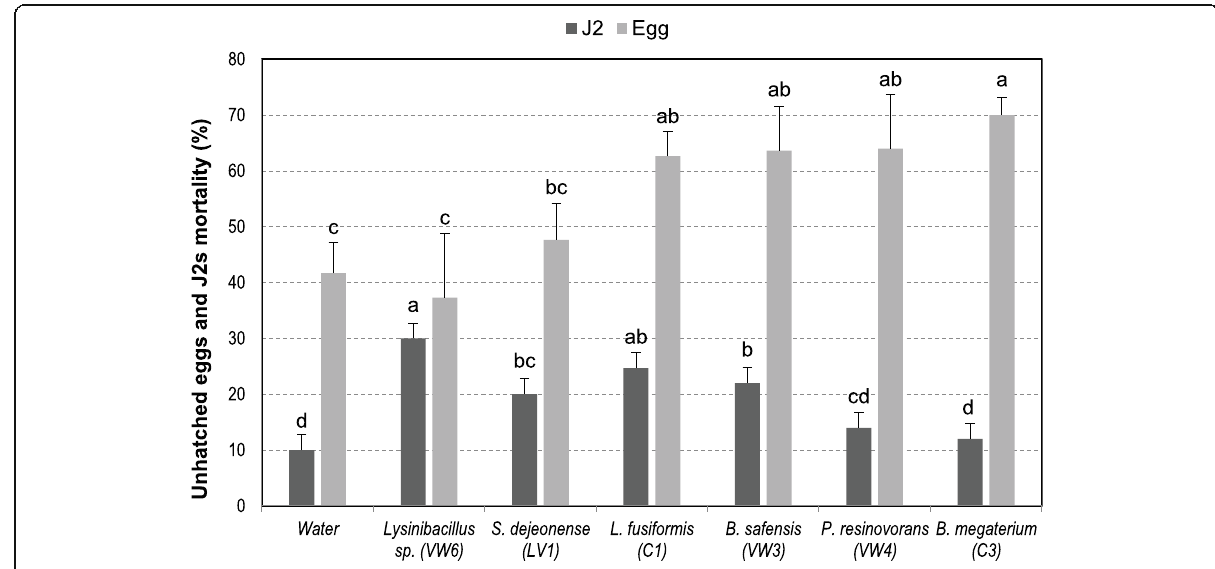
Fig. 1 Effect of bacteria isolates on egg hatching and mortality of the second-stage juveniles (J2s) of Meloidogyne javanica in vitro. Values in the same column followed by the same letter(s) are not significantly different ( P ≤ 0.05), according to Duncan ’ s multiple range test. Bars indicate the standard error of the means ( n = 3)